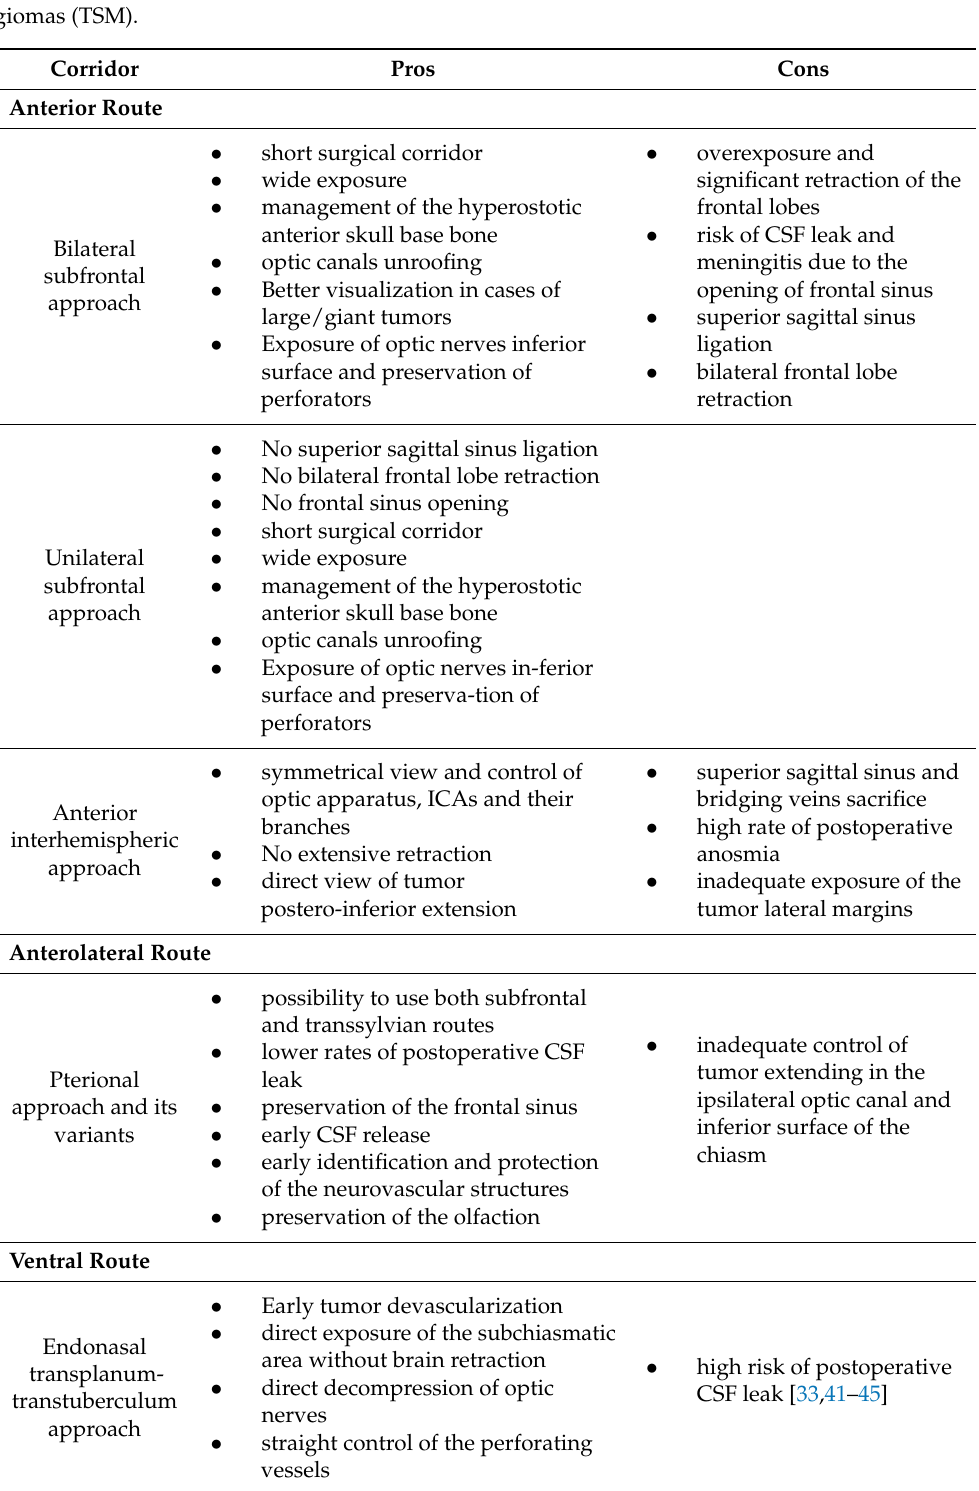
Table 3. Pros and cons for each corridor for the management of tuberculum sellae menin- giomas